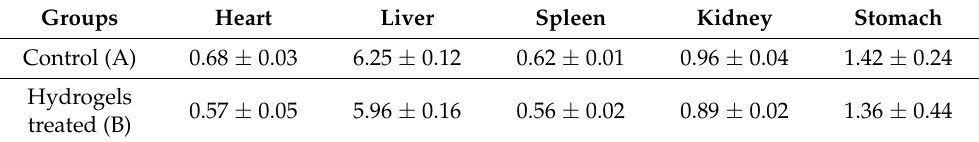
Table 5. Absolute weight of different vital organs (g) in control and hydrogel-treated group.